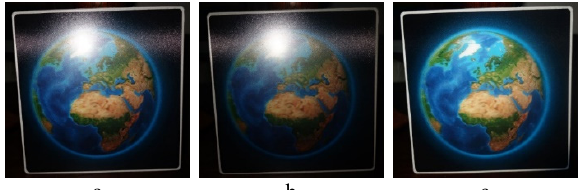
Figure 2. Experiment using polarised light source. Polarising filters are not in use (a), parallel (b) or crossed